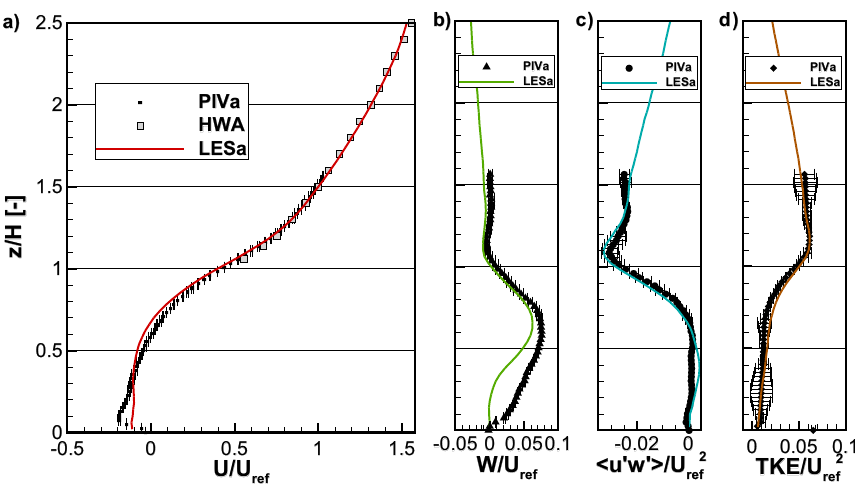
Figure 2. Comparison of the profiles of the mean dimensionless ( a ) streamwise and ( b ) vertical velocities, ( c ) momentum flux and ( d ) reduced turbulent kinetic energy at the centre of the street canyon ( x / H = 0). The solid lines represent the LES simulation; the symbols denote the wind-tunnel